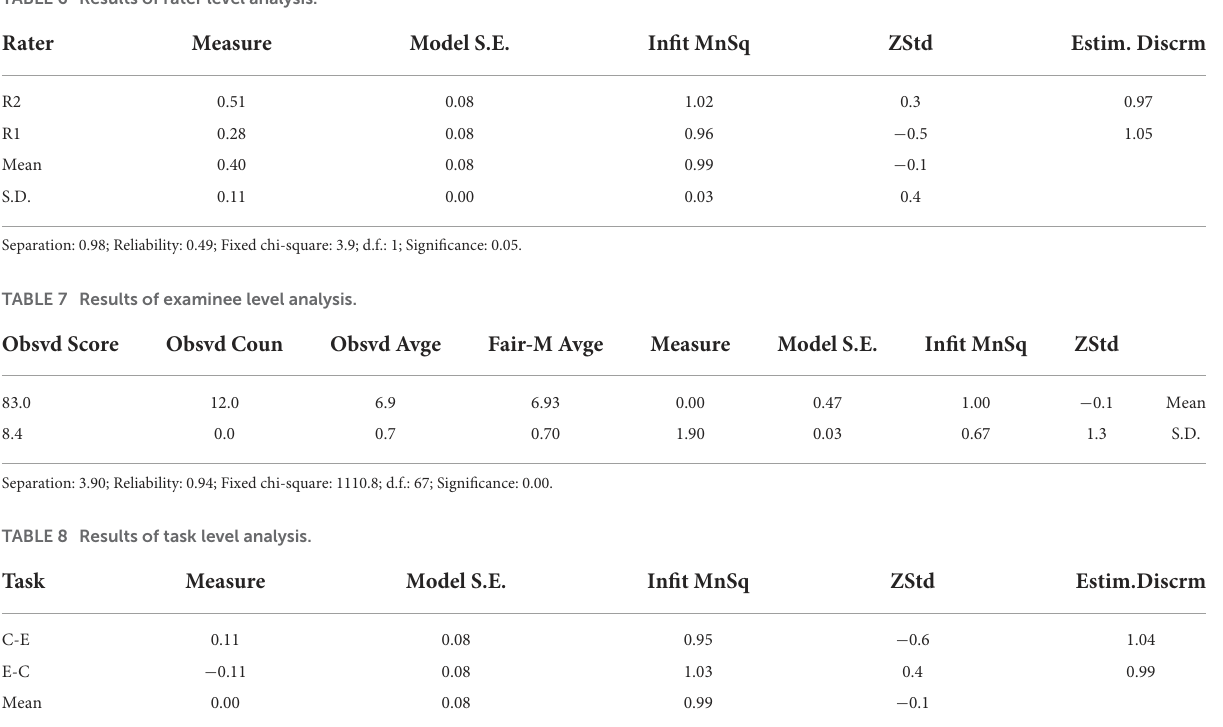
TABLE 6 Results of rater level analysis.